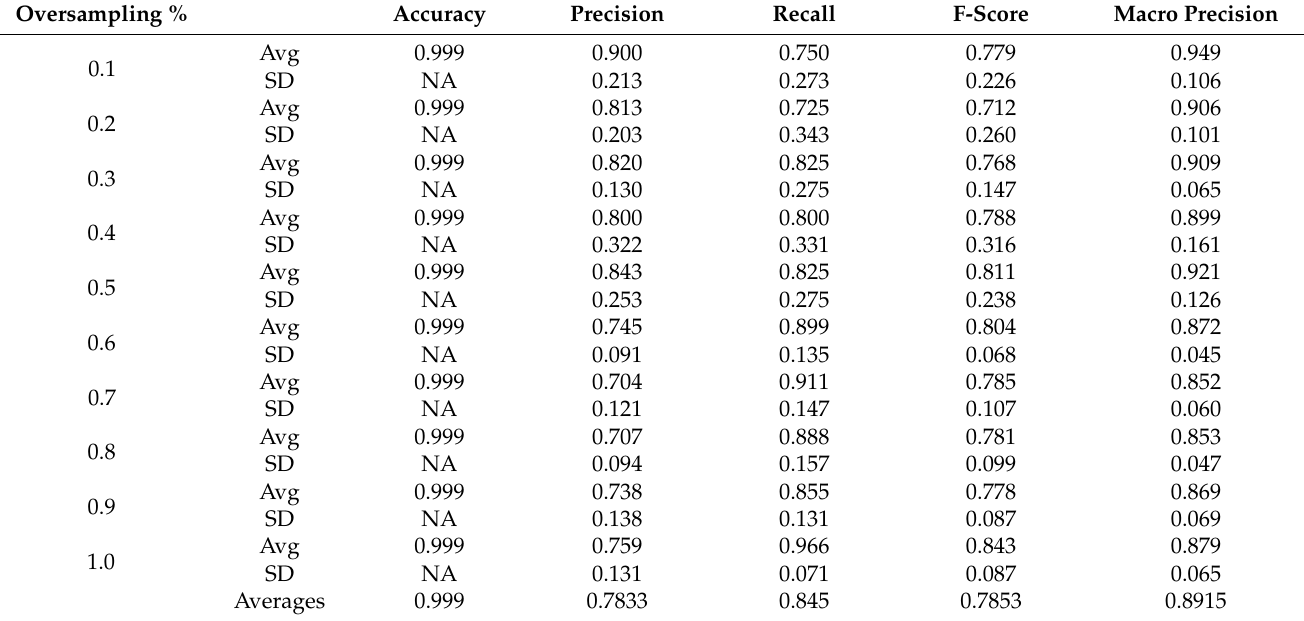
Table 23. UWF-ZeekData22: privilege escalation—classification results for random undersampling after splitting.